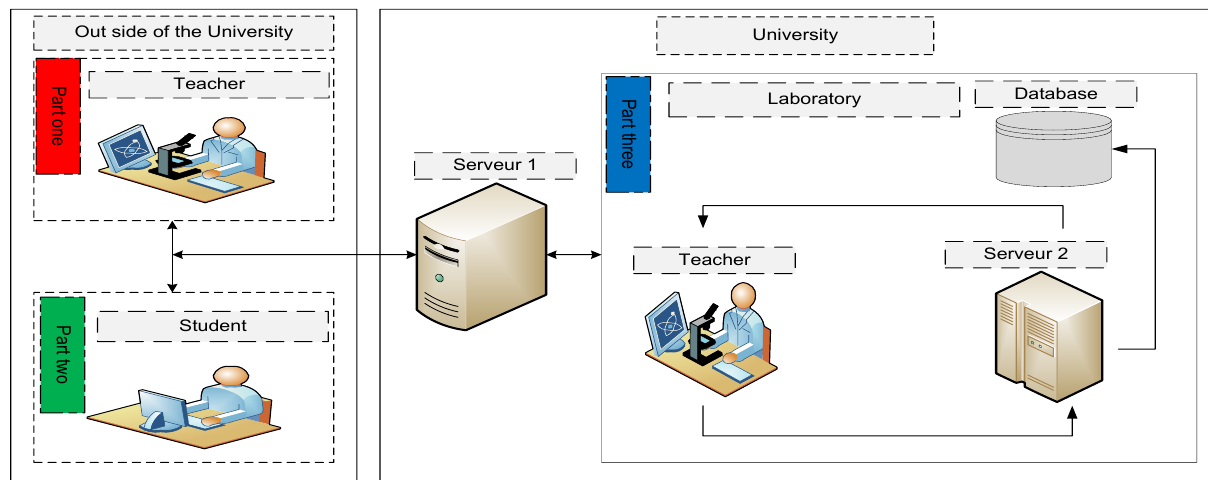
Figure 2. The architecture of the proposed